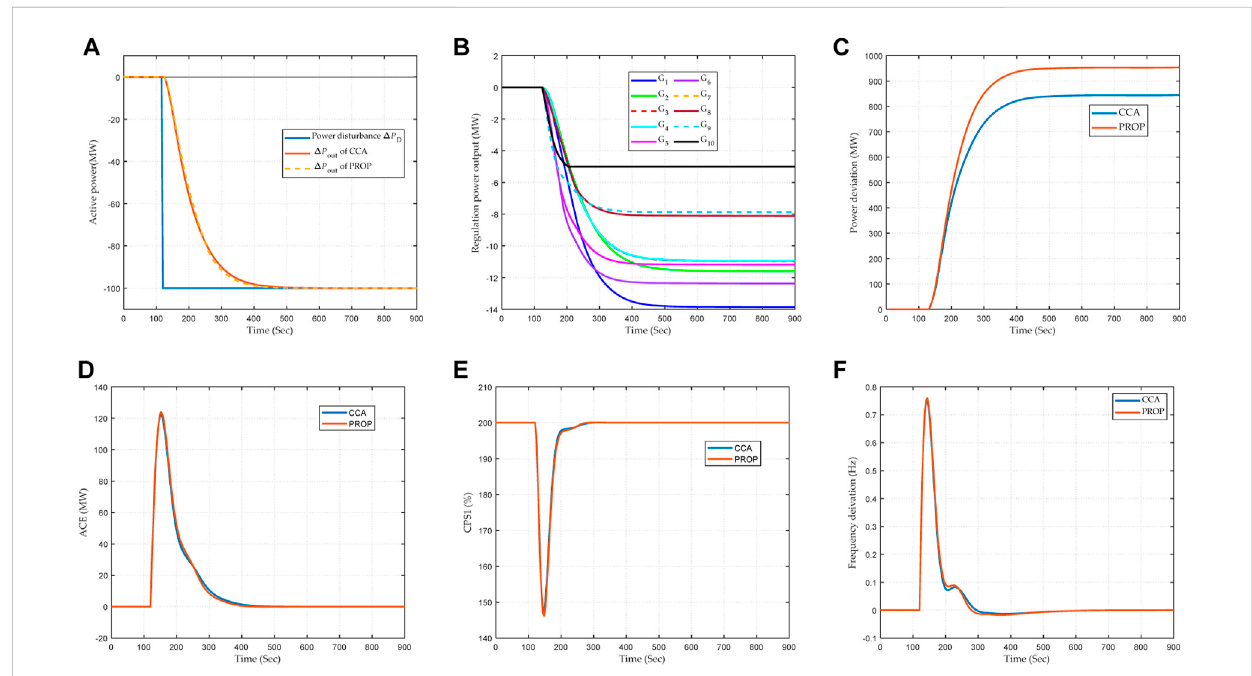
FIGURE 7 Dynamic power tracking schemes acquired by the proposed CCA and PROP at Δ P D (cid:2) − 100MW. (A) Power tracking curve. (B) Regulation resource output curves obtained by the proposed CCA. (C) Dynamic power deviation. (D) Dynamic ACE. (E) Dynamic CPS. (F) Dynamic frequency deviation.